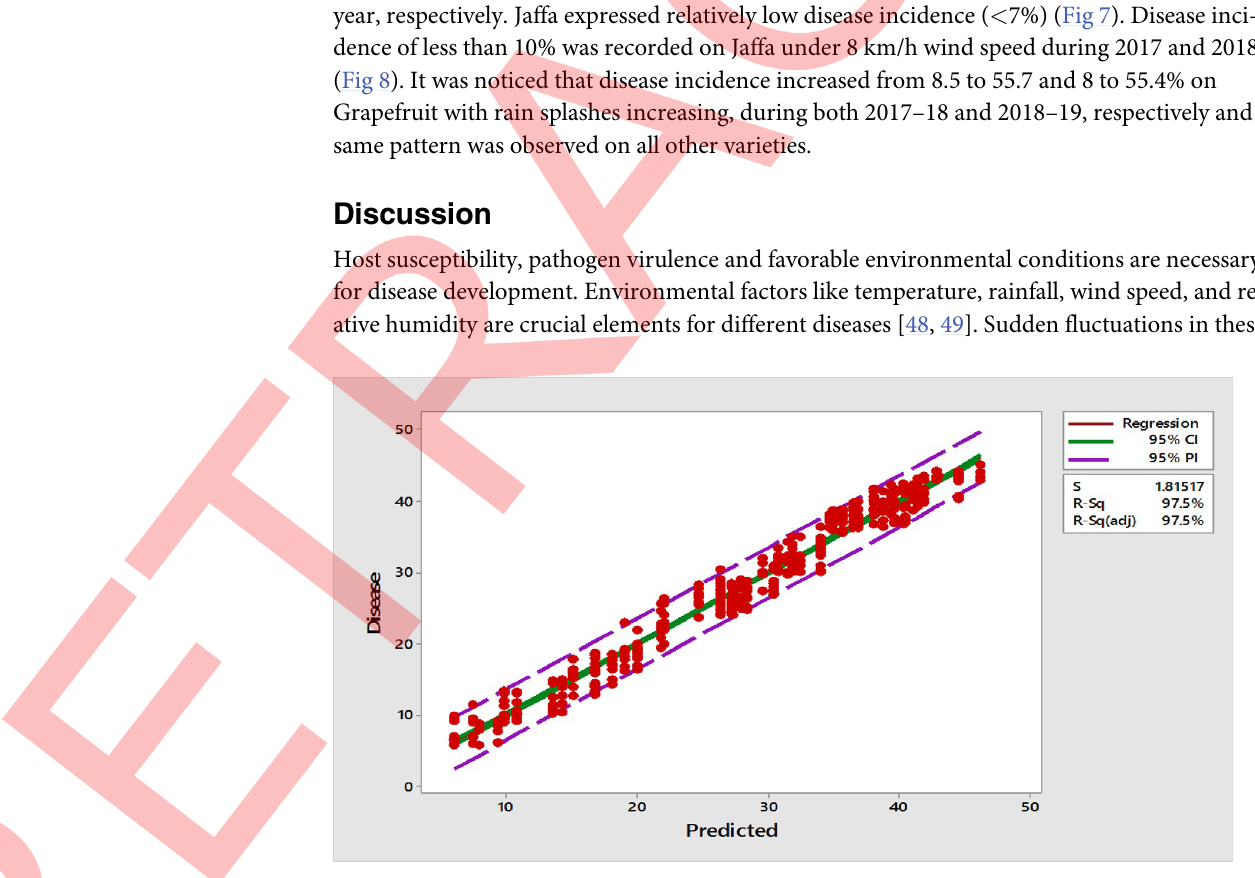
Fig 3. A fitted line plot for citrus canker disease with observed and predicted data points at 95% confidence and predictive